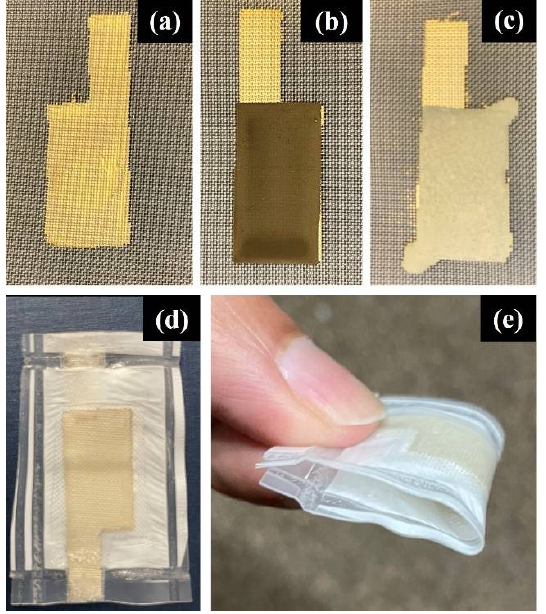
Figure 2. Printed ( a ) silver current collector layer; ( b ) silver oxide layer; and ( c ) zinc layer. The image of a printed flexible Ag 2 O-Zn battery ( d ) assembled in a polythene pouch; and ( e ) flexed to a bend radius of 0.2 cm.